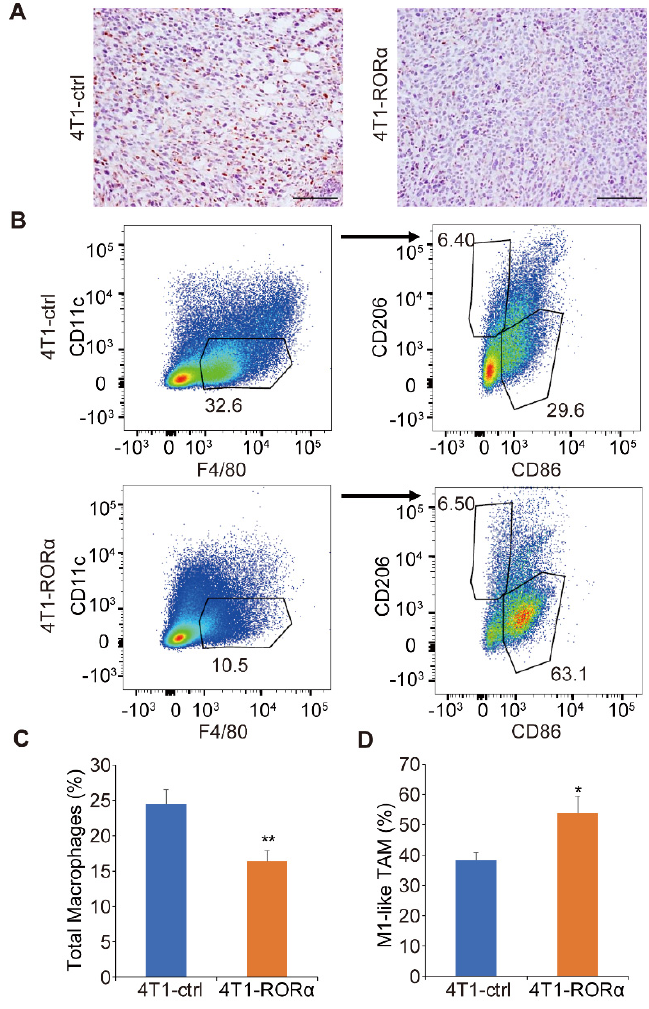
Figure 6. ROR α inhibits macrophage accumulation and M2 polarization in mammary tumor tissue. ( A ) Images showing the accumulation of F4/80 positive cells in control and ROR α -expressing 4T1 xenografts. Bar: 100 µm. ( B–D ) FACS analysis and quantification of macrophages isolated from control or ROR α -expressing 4T1 cells injected BALB/c mice; results are presented as mean ± SEM; n = 7, ** p < 0.01, * p < 0.05, student’s t-tests.